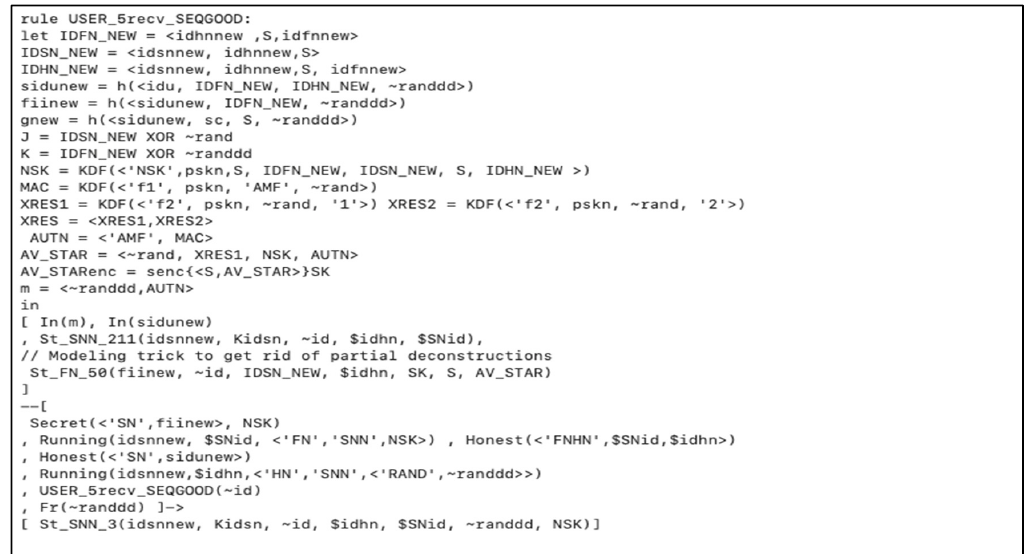
Figure 8. HN – FN authentication and new parameters creation.